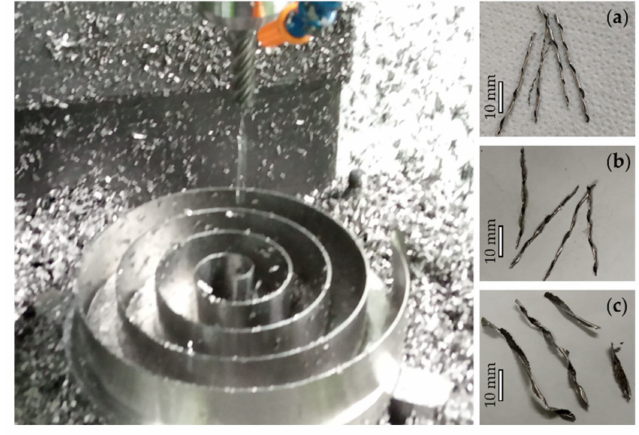
Figure 26. One of the milling processes and types of chips ( a – c ).